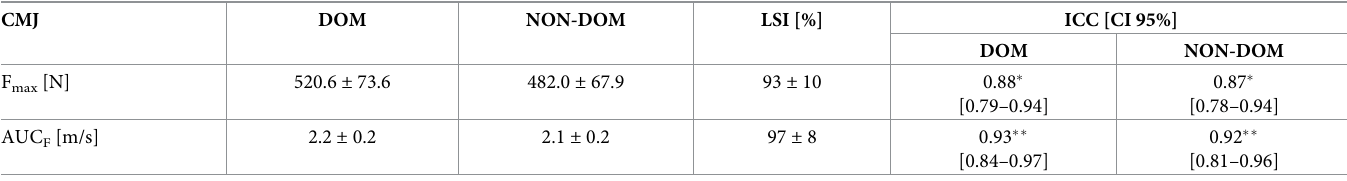
Table 2. Results of the two parameters estimated during the CMJ (mean ± standard deviation). CMJ